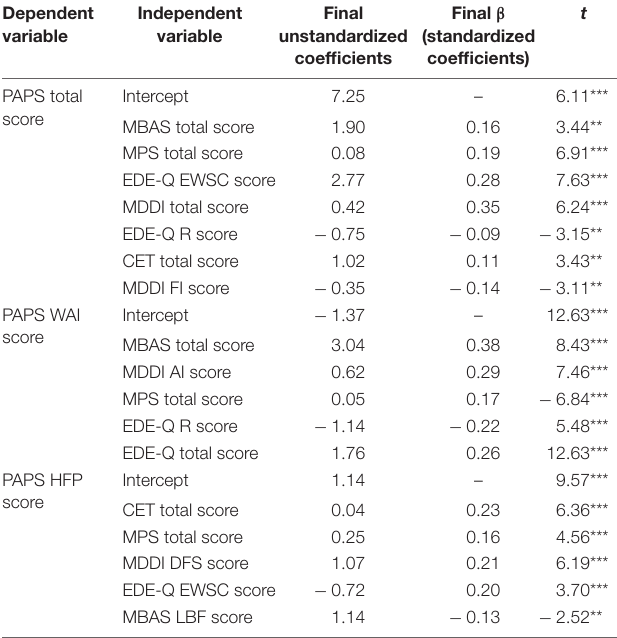
TABLE 5 | Multiple hierarchical regression: final regression coefficients for each dependent variable. Dependent